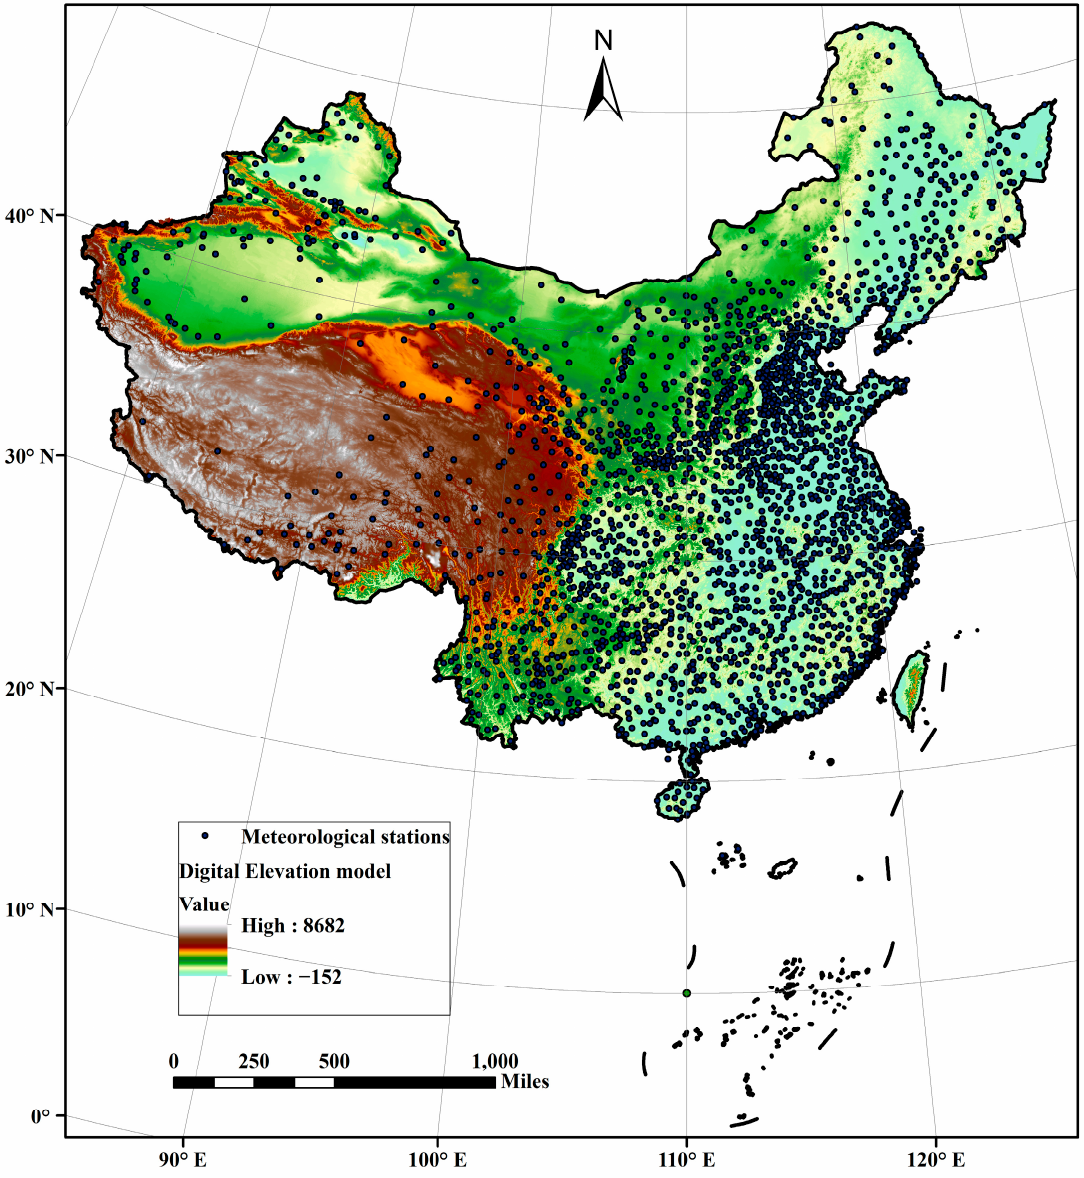
Figure 1. The research area and the spatial distribution of 2419 national meteorological stations in China.